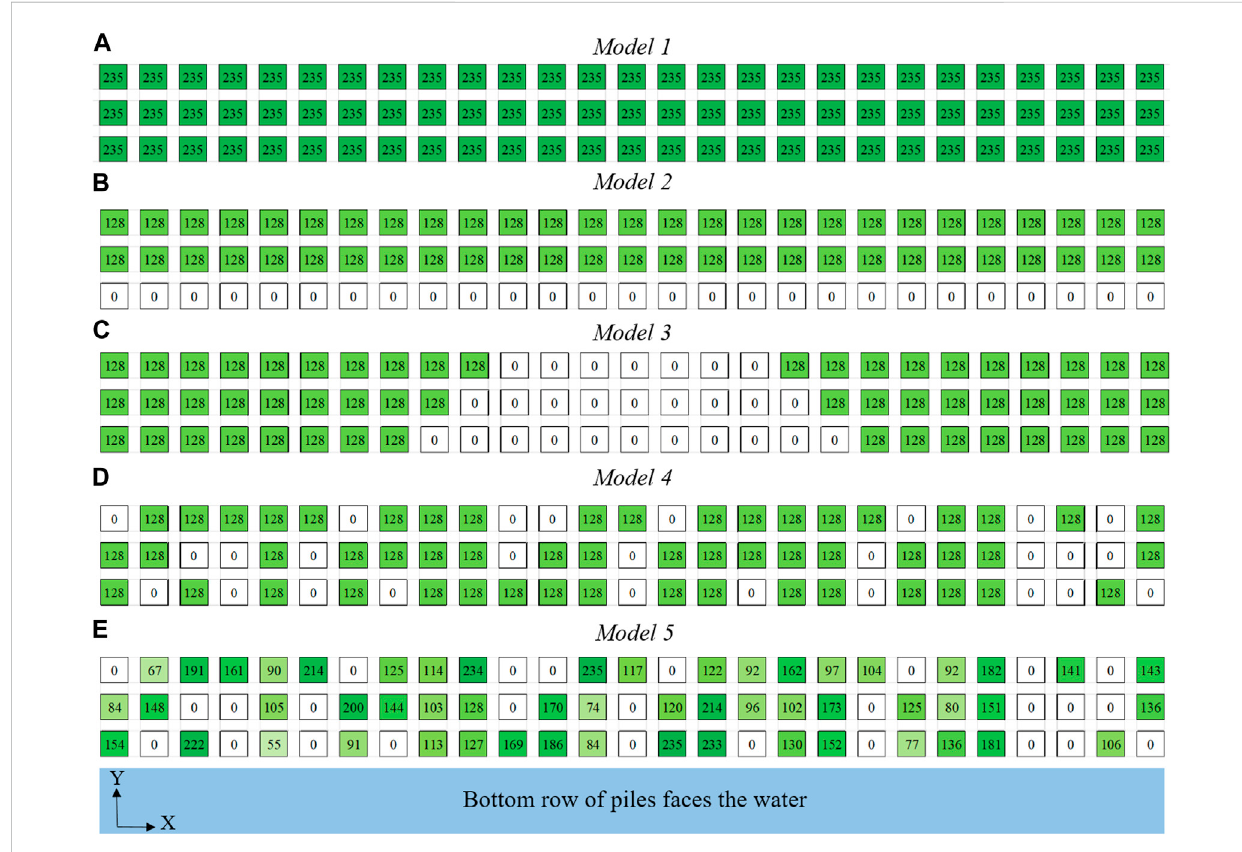
FIGURE 7 Pile cap diameters considered during application of traf fi c loads: (A) Model 1 (B) Model 2 ; (C) Model 3 ; (D) Model 4 and (E) Model 5 . Plan view: each square corresponds to a pile. All dimensions are in mm.